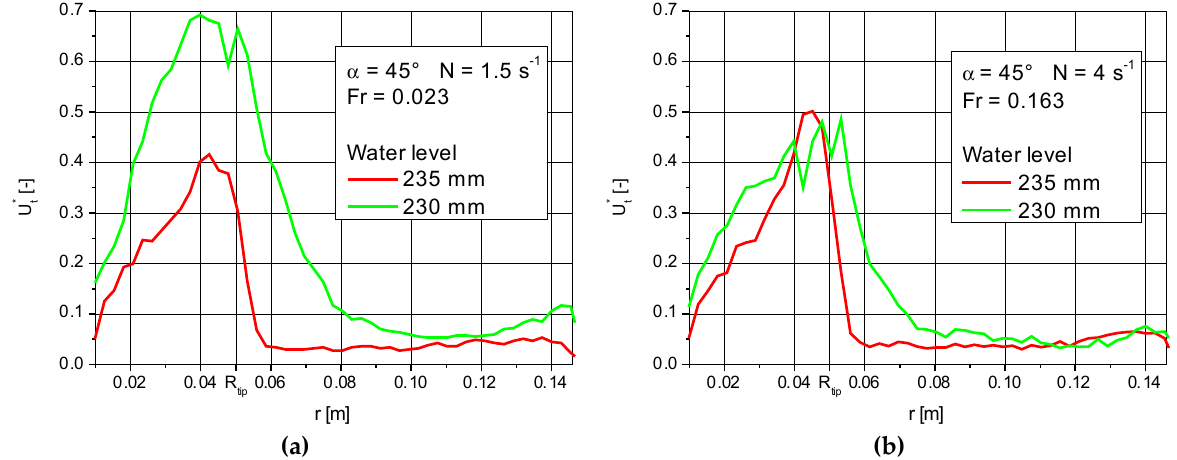
Figure 5. The distribution of peripheral velocity in the tank with a diameter of T = 292 mm ( a ). N = 1.5 s − 1 , ( b ). N = 4 s − 1